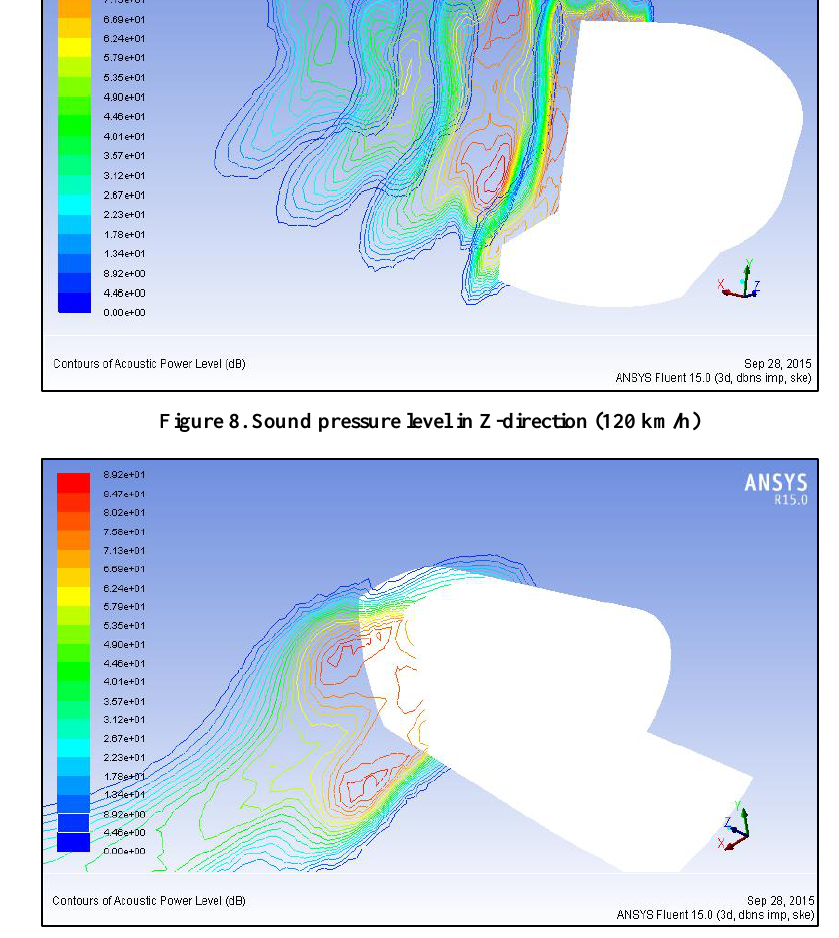
Figure 9. Sound pressure level in X-direction (120